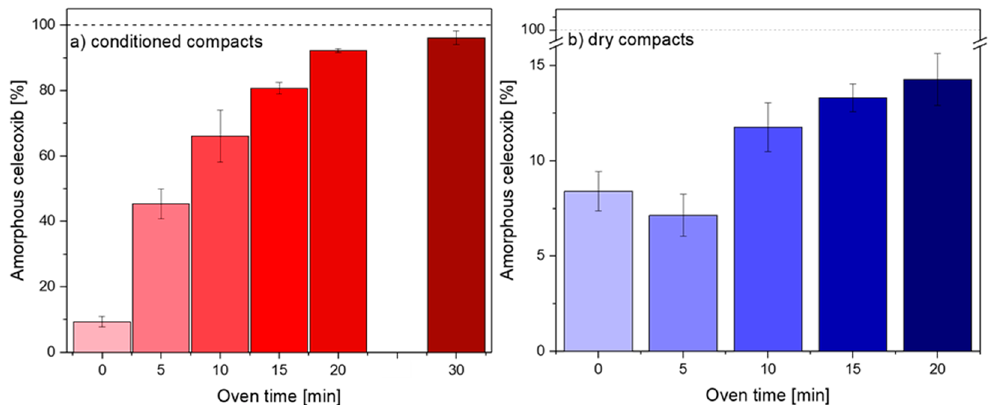
Figure 1. Degree of amorphization of celecoxib (CCX) quantified by transmission Raman spectroscopy for ( a ) conditioned (red) and ( b ) dry (blue) compacts after different times in the convection oven (0, 5, 10, 15, 20 and 30 (only Figure 1a) min). Data represents mean ± SD ( n = 3, n = 12 (0 min)).